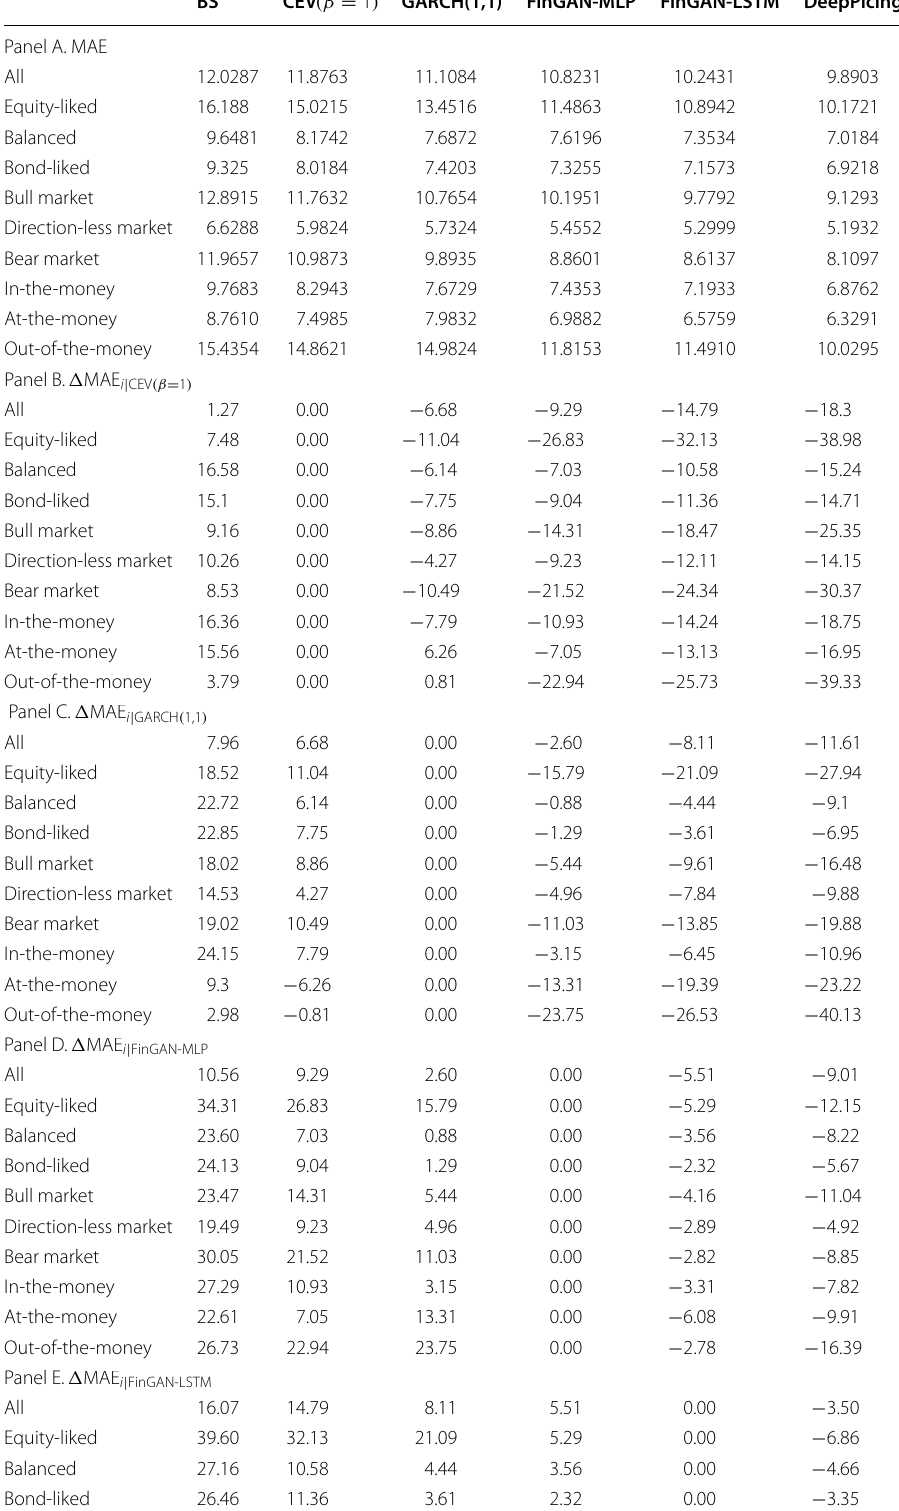
Table 5 Pricing performance across different models: MAE